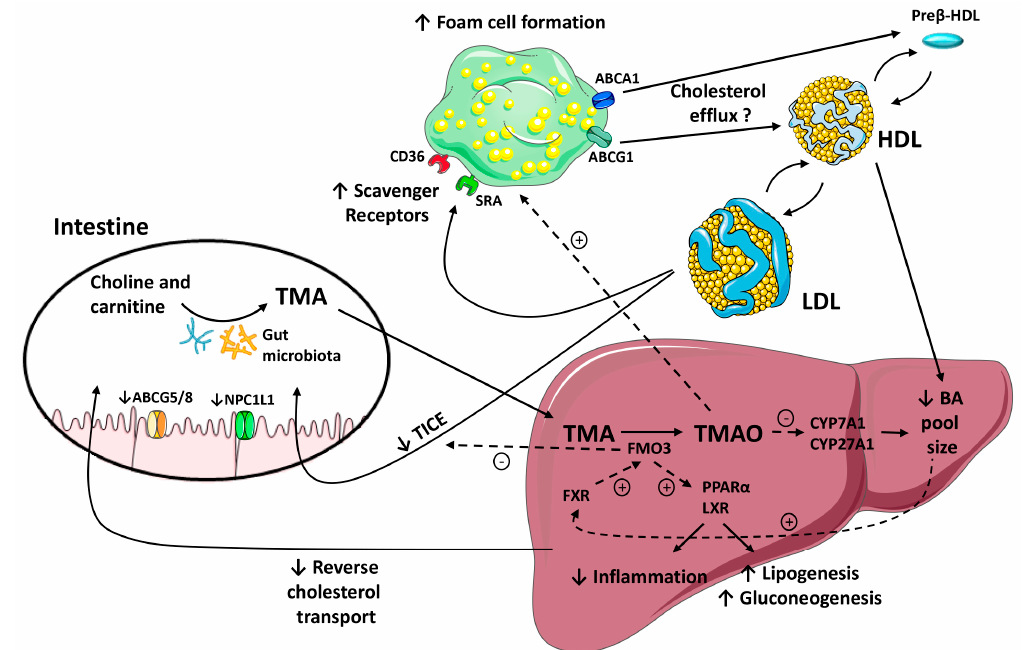
Figure 2. A schematic representation of pathways linking the gut microbiota, the formation of trimethylamine- N -oxide (TMAO) by flavin monooxygenase (FMO) 3 and the regulation of enterohepatic bile acid (BA) and cholesterol metabolism and macrophage reverse cholesterol transport (RCT) pathways. Black arrows indicate movement of TMA/TMAO and cholesterol through the body. Blunt-end arrows indicate activation (+) or inhibition (-) of specified receptors and transporters or pathways. Gut microbiota metabolism of choline and L -carnitine results in the formation of trimethylamine (TMA). In the liver, FMO3 converts TMA into TMAO. The potential effects of TMAO on the proatherogenic pathways include the promotion of foam cell formation by increasing macrophage scavenger receptors ( ↑ ) and the downregulation of the main liver bile acid (BA) synthetic enzymes, cyp7a1 and cyp27a1. Downregulation of these rate-limiting enzymes reduces intracellular levels of BA ( ↓ ). The BA pool size could impact the farnesoid X receptor (FXR)-mediated regulation of FMO3. In turn, this enzyme may regulate the liver X receptor (LXR) and peroxisome proliferator-activated receptor (PPAR) α signaling pathways, reducing liver inflammation ( ↓ ) and promoting hepatic lipogenesis and gluconeogenesis ( ↓ ). FMO3 impairs the cholesterol flux into the nonbiliary transintestinal cholesterol export (TICE) pathway ( ↓ ). TMAO also reduces Niemann-Pick C1-Like 1 (NPC1L1) and adenosine triphosphate-binding cassette (ABC) G5/G8 expression ( ↓ ), and inhibits intestinal cholesterol absorption. Collectively, the effects of TMAO/FMO3 on BA homeostasis and TICE impair the macrophage-to-feces RCT ( ↓ ).